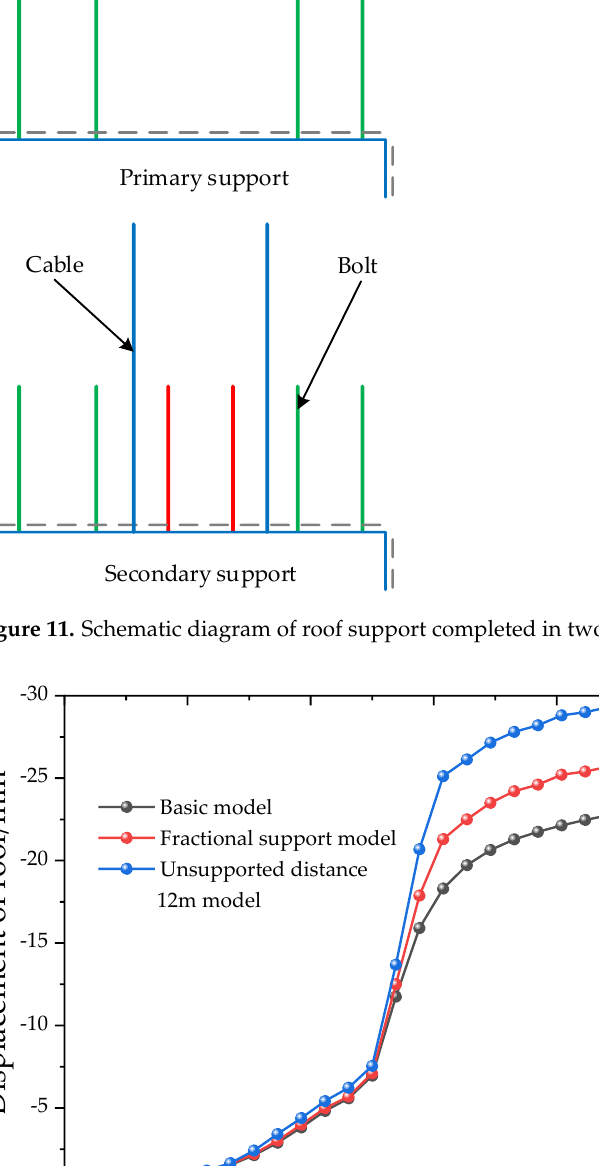
Figure 13. Geological survey of 122,110 auxiliary transport roadway. The Caojiatan Coal Mine has simple geological conditions and is less affected by tectonic areas. However, the thickness of the coal seam is large, the roadway is driven along the floor, the direct roof is the coal body with low strength, and the roadway section